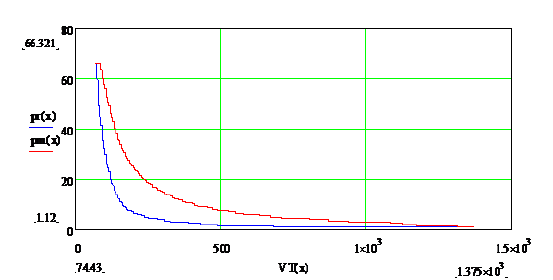
Figure 4. The indicated diagram for the thermal chamber